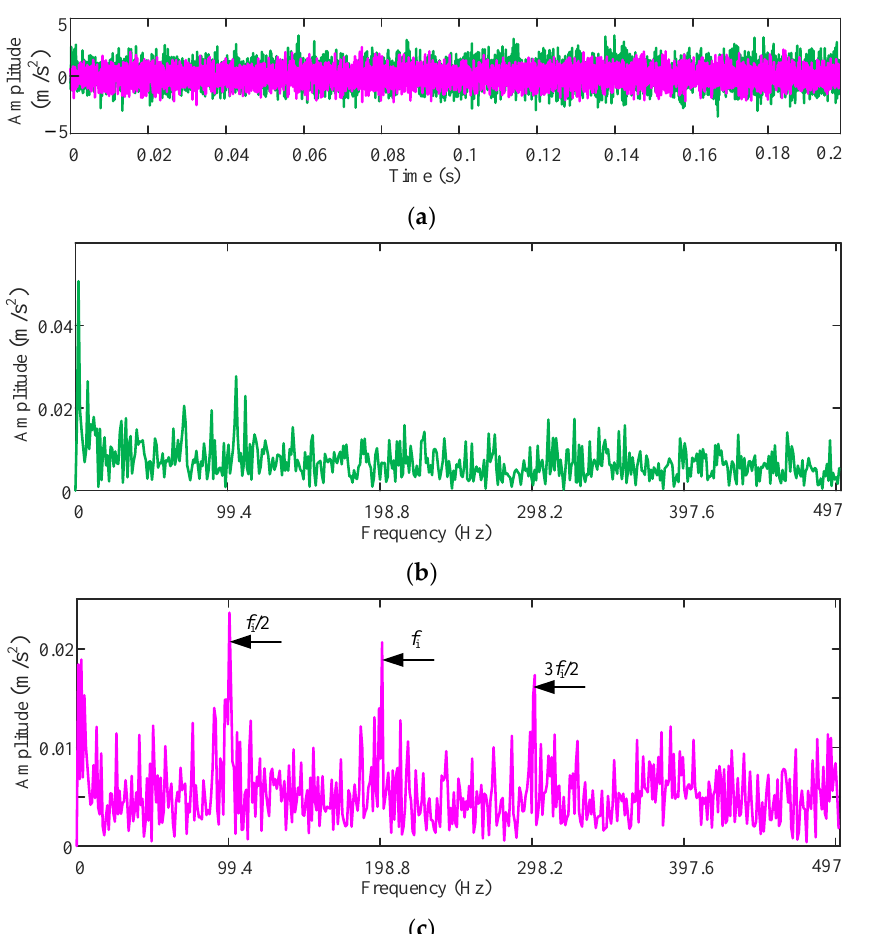
Figure 16. Waveform and envelope spectrum of vibration signal and noise reduction signal in Case 2. ( a ) Waveform of vibration signal and noise reduction signal; ( b ) Envelope spectrum of vibration signal; ( c ) Envelope spectrum of noise reduction signal.